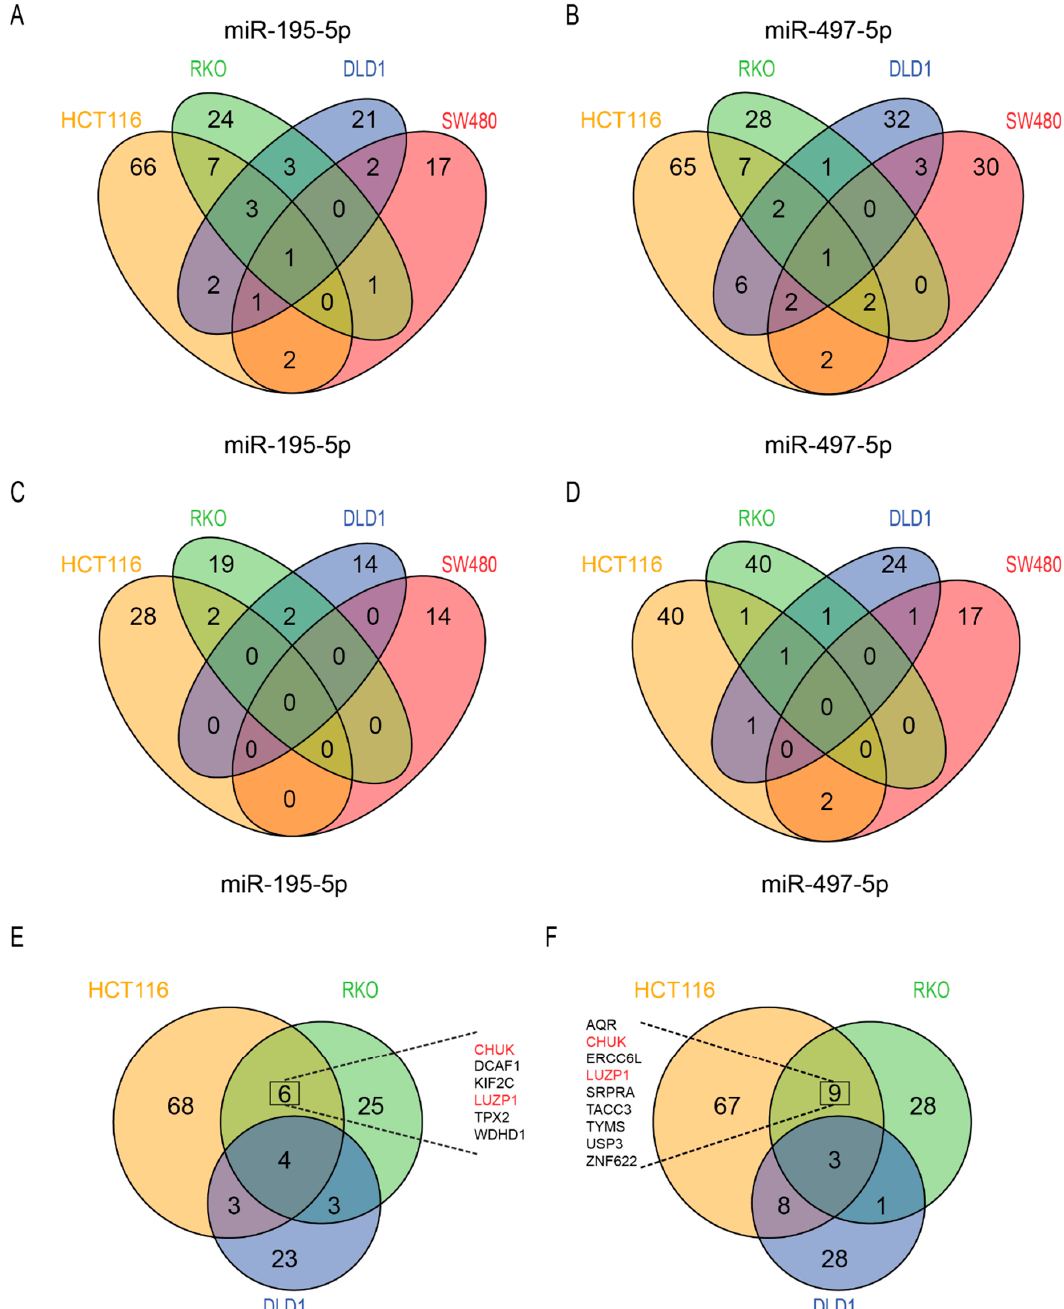
Figure 4. Number of significantly differential expressed proteins after transfection with miR-195-5p and miR-497-5p miRNA mimics. Venn diagram of the downregulated proteins in the four cell lines after transfection with mimics of miR-195-5p ( A ) and miR-497-5p ( B ). Venn diagram of the upregulated proteins in the four cell lines after transfection with mimics of miR-195-5p ( C ) and miR-497-5p ( D ). Venn diagram of overlapping downregulated proteins in MSI CRC cells after transfection with mimics of miR-195-5p ( E ) and miR-497-5p ( F ). Coinciding significantly differential expressed proteins in MSI/P53 wt CRC cells transfected with miR-195-5p mimic and miR-497-5p mimic are listed in ( E ) and ( F ) respectively. In red two proteins downregulated in all four conditions. 3.5. Target Analysis of Overlapping Downregulated Proteins in RKO and HCT116 Cells